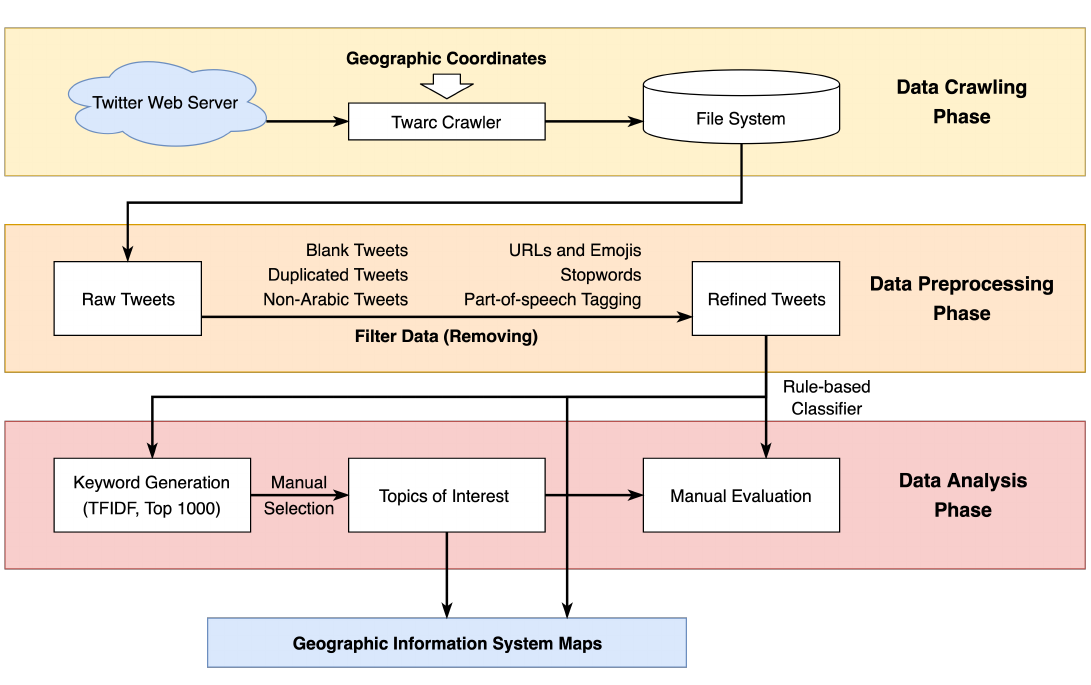
Figure 1. An overview of the three phases in our proposed